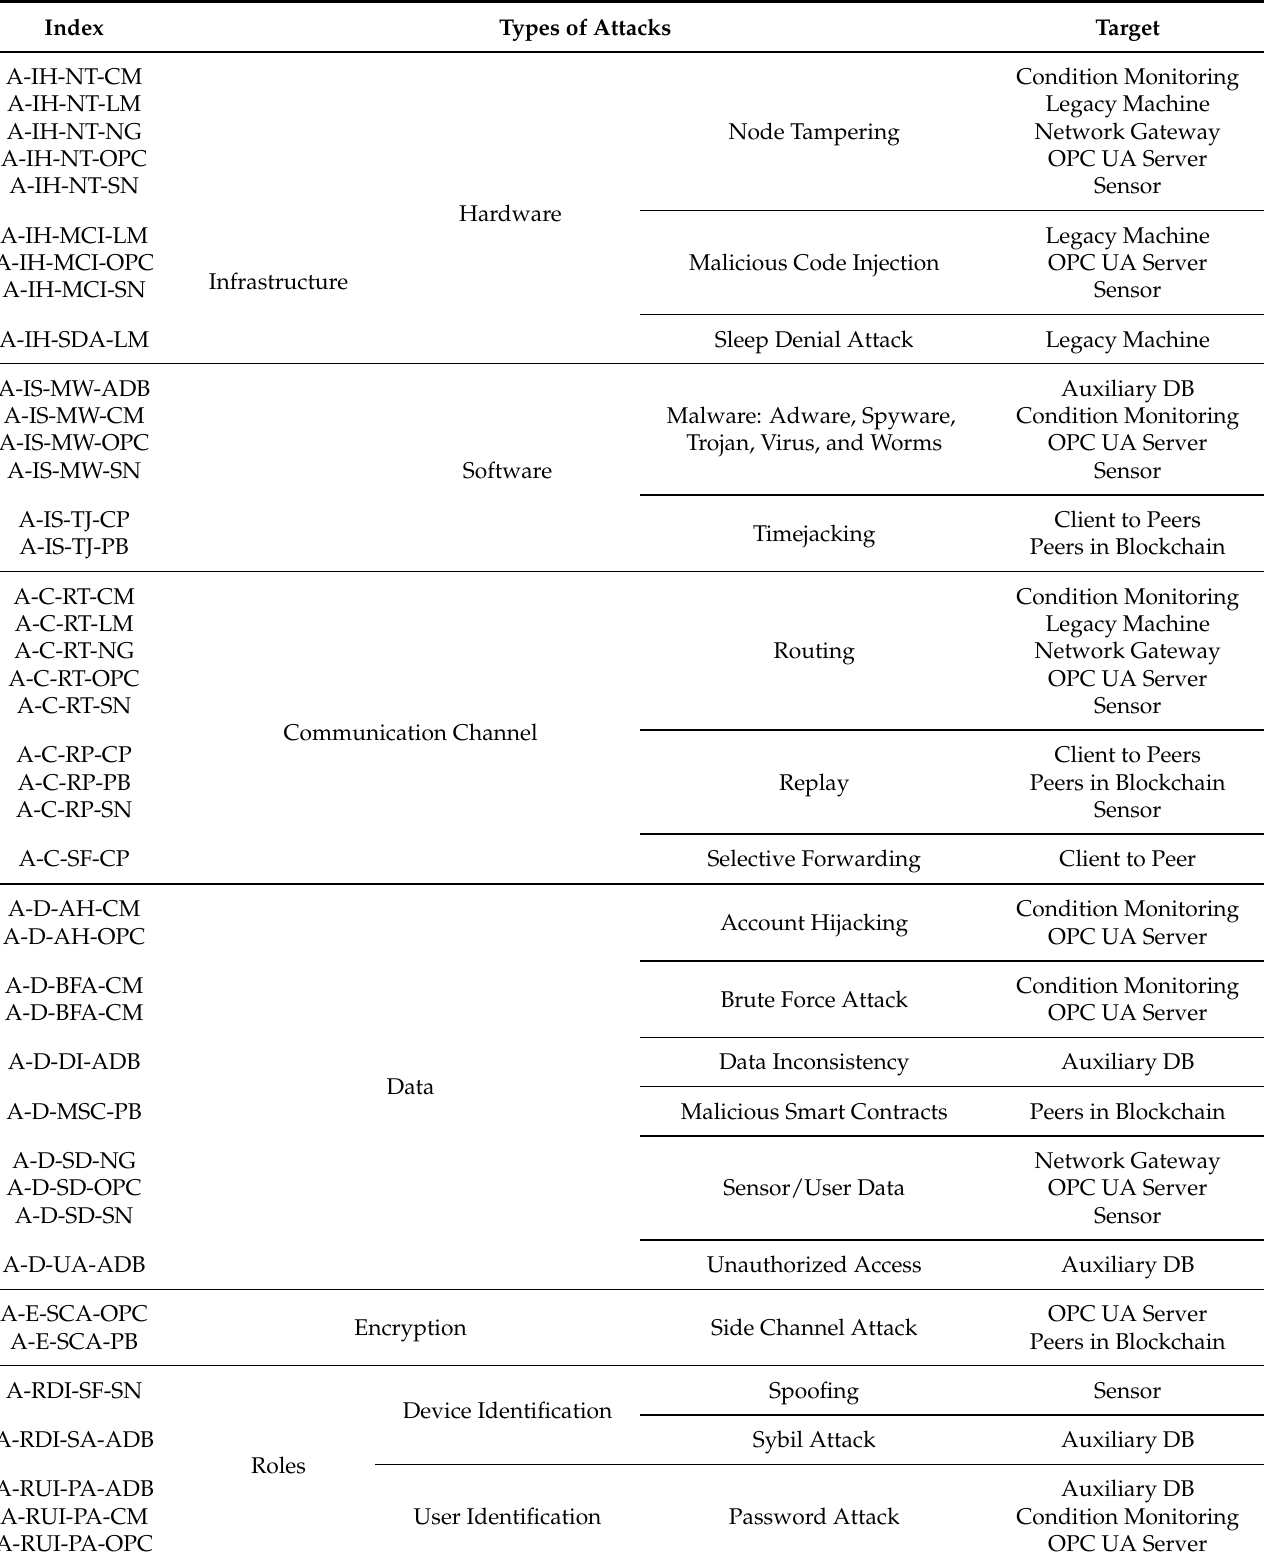
Table 1. Overview of